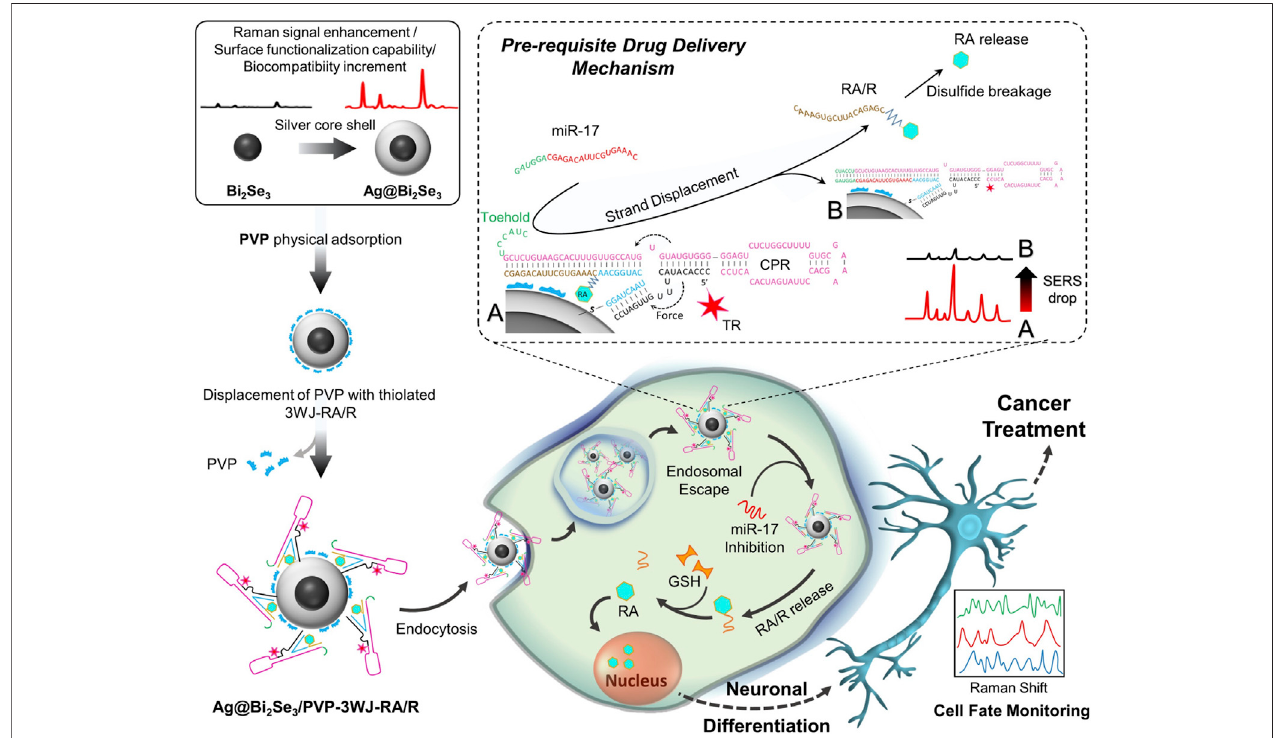
FIGURE 7 | Nanotechnology for induction of differentiation in NB. Schematic diagram of the Ag@Bi2Se3/PVP-3WJ-RA/R fabrication and its application in NB cell differentiation. Reproduced with permission from: Mohsen Mohammadniaei, Jinho Yoon, Hye Kyu Choi, Virginie Placide, Bapurao Gangaram Bharate, Taek Lee and Jeong-Woo Choi. Multifunctional Nanobiohybrid Material Composed of Ag@Bi(2)Se(3)/RNA Three-Way Junction/miRNA/Retinoic Acid for Neuroblastoma Differentiation. ACS applied materials & interfaces, 2019, 11(9): 8779 – 8788 (Mohammadniaei et al., 2019). Copyright 2019, American Chemical Society.